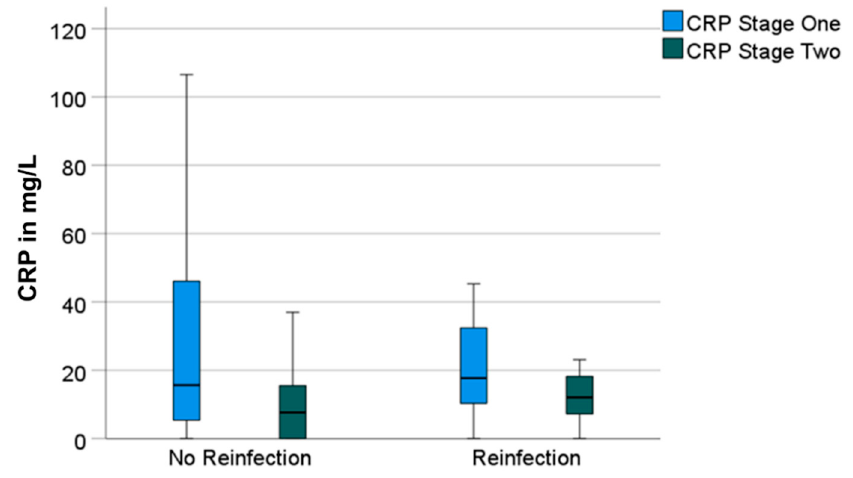
Figure 1. Boxplots for C-reactive protein (“CRP“) values prior to stage-one and prior to stage-two surgeries, divided in groups without and with reinfection.